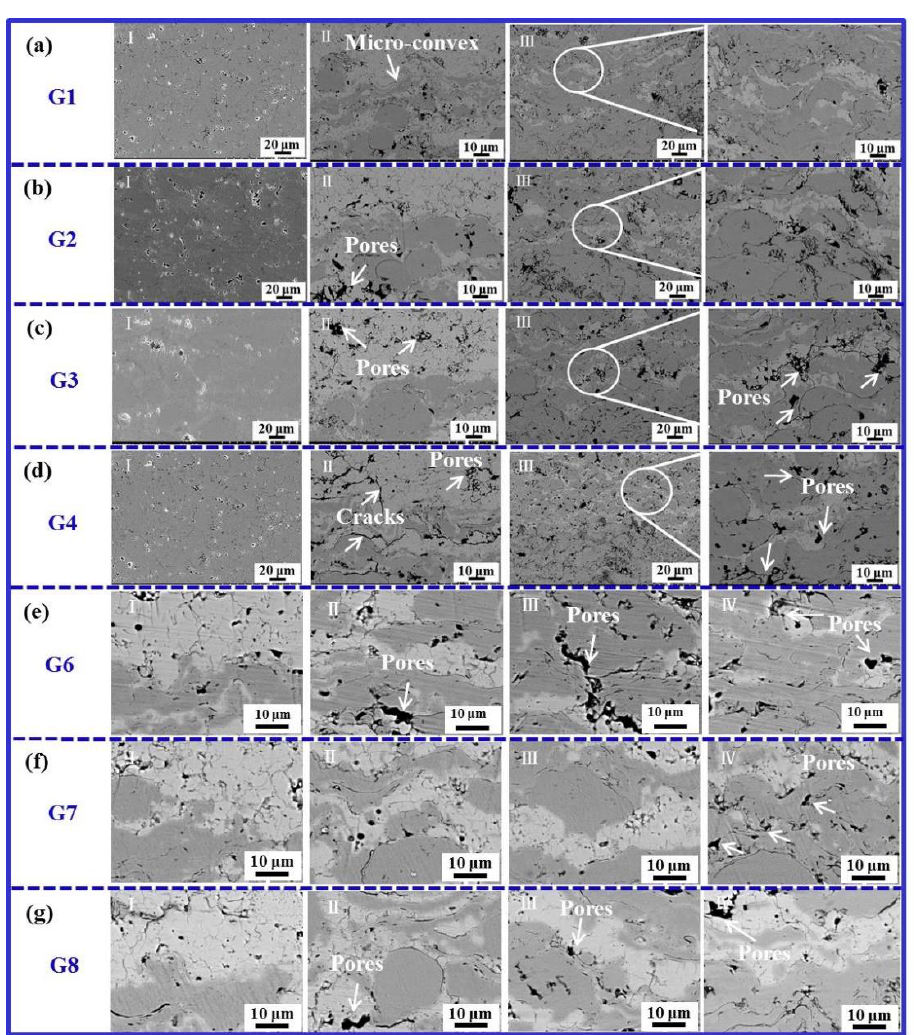
Figure 6. Higher magnification images of gradient NiCoCrAlY/YSZ coating at the different re- gions: ( a ) G1, ( b ) G2, ( c ) G3, ( d ) G4, ( e ) G6, ( f ) G7 and ( g ) G8.